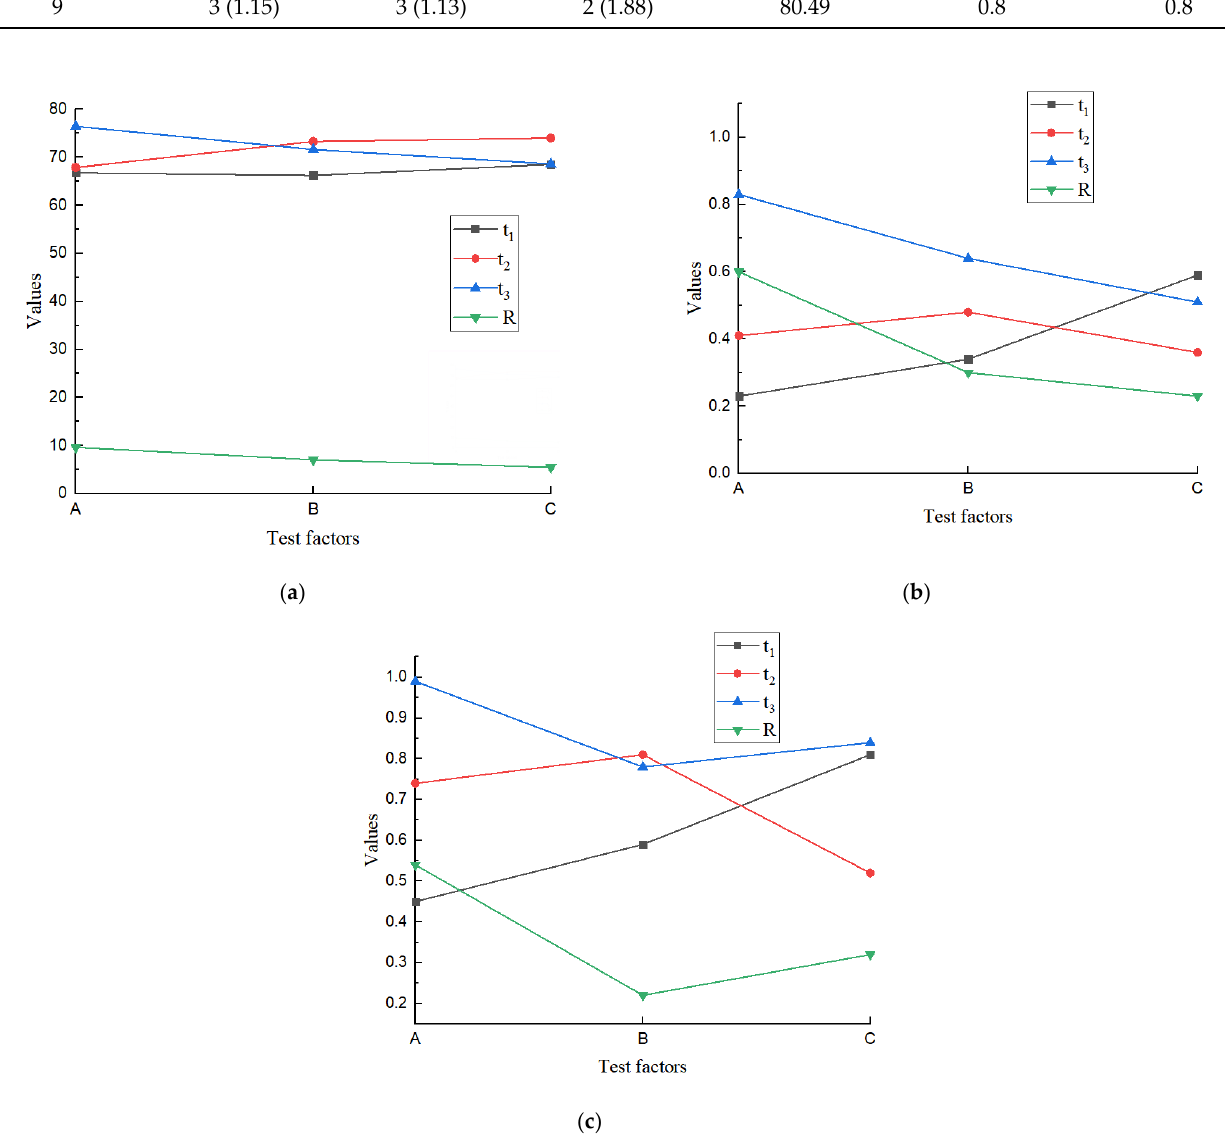
Figure 6. Range analysis of pressed vine experiment results, ( a ) P m , ( b ) P s , ( c ) P f